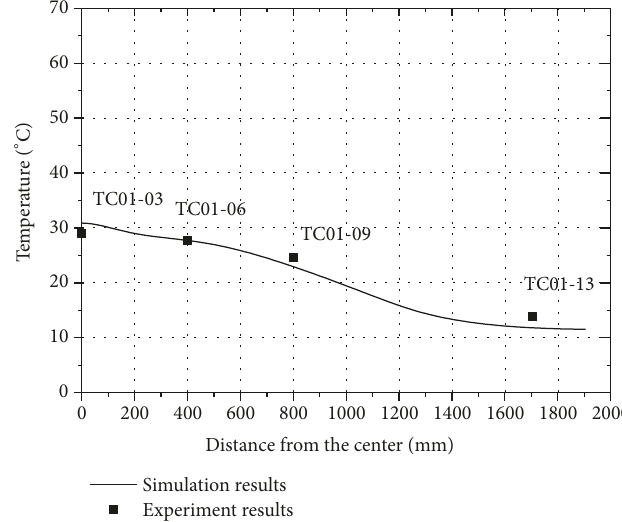
Figure 20: The temperature contrast of simulation and experiment at the bottom plate in Test